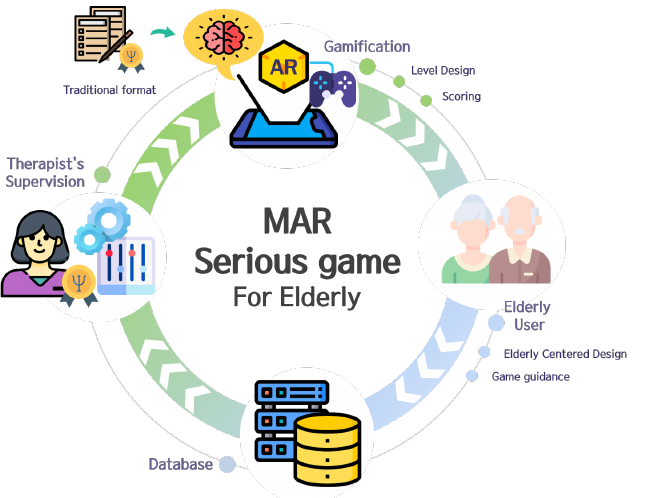
Figure 4. Proposed mobile AR Serious game. Icons from www.flaticon.com (accessed on 29 June